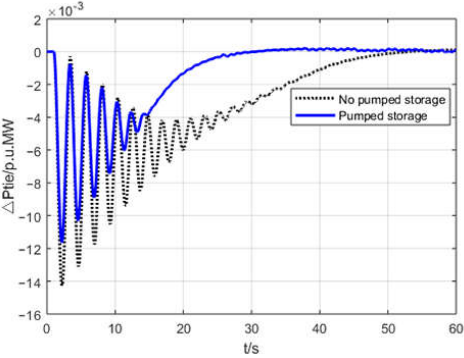
Figure 11. (cid:52) P tie variation chart at pumping operation Figure 11. △ P tie variation chart at pumping operation mode. Figure 11. △ P tie variation chart at pumping operation mode.